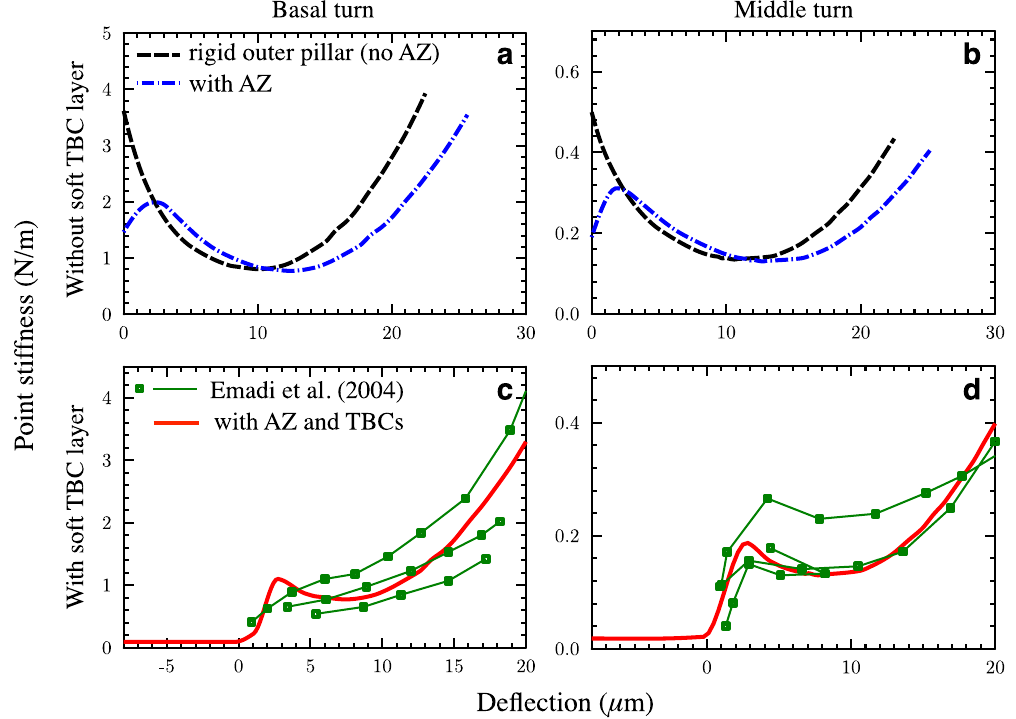
Figure 3. Point-stiffness vs. deflection plots from the ABM, without ( a,b ) and with ( c,d ) the soft TBC layer. The left column ( a,c ) is for the basal turn (2.8 mm from the stapes), while the right column ( b,d ) is for the middle turn (6 mm from the stapes). ( a,b ) Effects of a rigid outer pillar (black dashed lines; using the model in Fig. 1c) and of the full model (Fig. 1d) with an AZ and compliant outer-pillar support (blue dash-dotted lines). ( c,d ) The first plateau ( < 0 μ m deflection) of the model with TBCs (red lines; using the model in Fig. 1d) is due to the compression of the soft TBC layer, which delays the buckling behavior of the arch until near the second plateau (6–10 μ m deflection). The stiffness of the second plateau and of the following region of quadratic stiffening corresponds well to measurements at both locations (thin green lines with square markers from ref. 24). The key model parameters are L e = 1400 μ m and 3800 μ m for the basal and mid-turn locations, c = 0.87, and E = 2